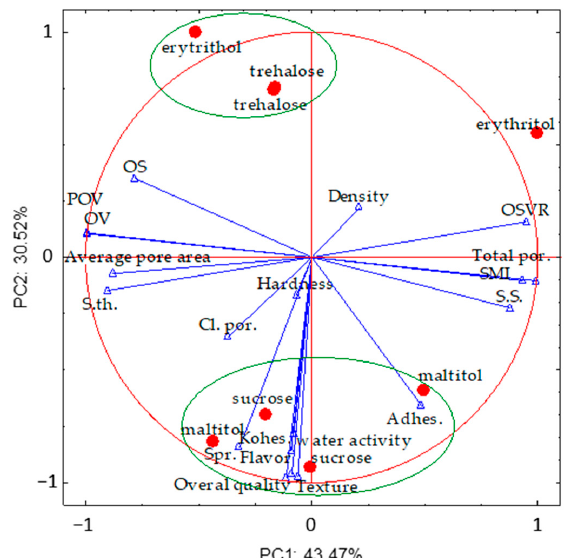
Figure 5. PCA diagram. Structural parameters: Cl. por., closed porosity; Total por., total porosity; POV, percent object volume; OSVR, object surface/volume ratio; OV, object volume; OS, object surface; SMI, structure model index; S.Th, structural thickness; S.Sp, structure separation. Mechanical parameters: Hardness; Cohes., cohesiveness; Adhes., adhesiveness; Spr., springiness. Sensory parameters: Texture; Overall quality;